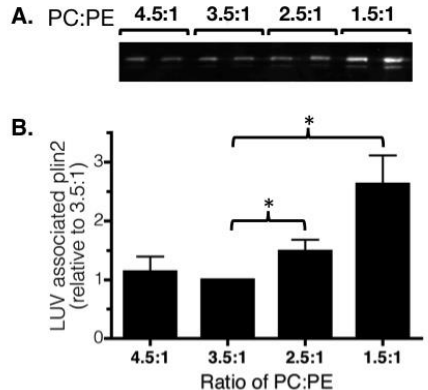
Figure 5. A decrease in the amount of phosphatidylcholine (PC) relative to phosphatidylethanolamine (PE) promoted perilipin 2 binding to large unilamellar vesicles (LUVs). ( A ): A representative Western blot of perilipin 2 in equivalent amounts of floating LUV fractions is shown. ( B ): Perilipin 2 abundance in LUV fractions was quantified. Data are expressed relative to the PC:PE ratio detected in hepatic LDs from control animals (3.5:1) and are mean values ± SEM from six to seven experiments. (*, p < 0.02, Wilcoxon signed-rank